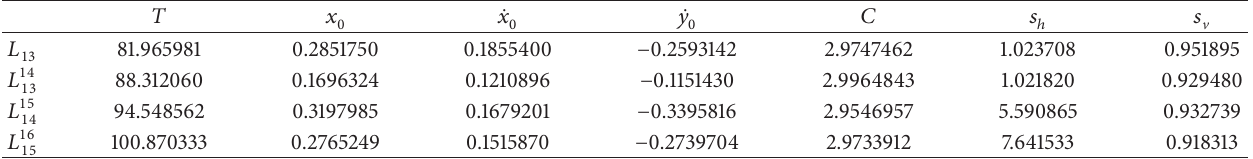
Table 1: Sample members of the long period family emanating from the triangular equilibrium point 𝐿 4 for the Sun-Jupiter system of the classical restricted three-body problem ( 𝜇 =